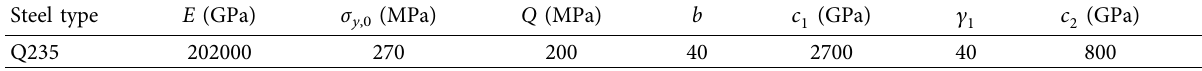
Table 1: Material parameters of Chaboche constitutive model for Q235 steel.